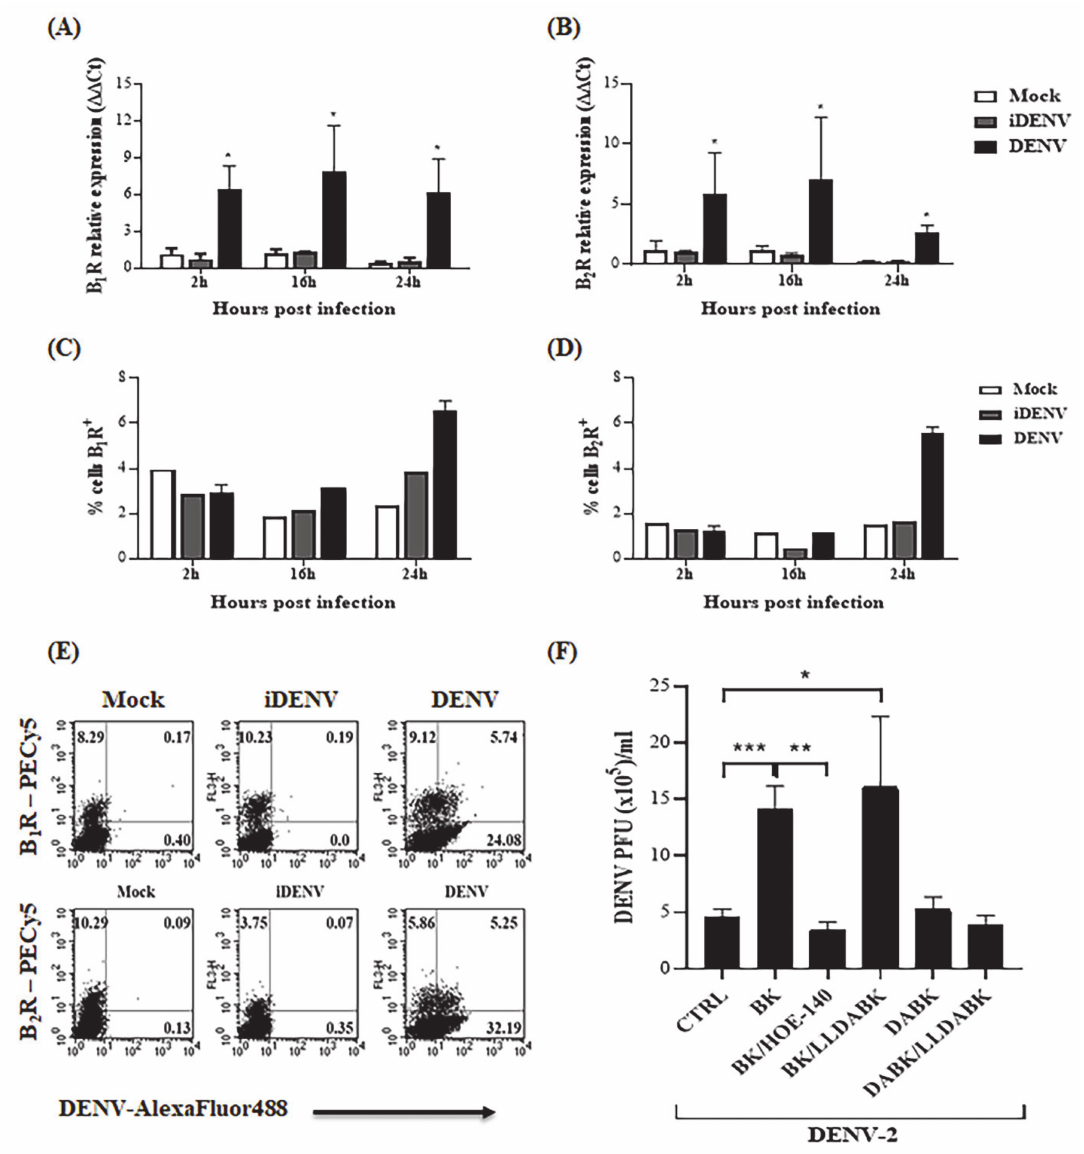
Figure 1. Bradykinin enhances DENV infection in HBMECs in a B2R-dependent way. ( A – D ) HBMECs were mock-treated or cultured with DENV-2 in its native or UV-inactivated forms (iDENV) for the indicated time points. ( A , B ) The expression of B1R and B2R mRNA were evaluated by qRT-PCR. ( C , D ) HBMECs were either incubated with goat anti-B1R antibodies or rabbit anti-B2R (Invitrogen), fixed and stained with secondary anti-goat or anti-rabbit antibodies, respectively. Surface expression of B2R and B1R in HBMECs was measured by flow cytometry; the results are exhibited as the percentage of cells expressing the receptors (% cells), considering staining values obtained in absence of primary antibodies as controls. ( E ) HBMECs cultivated for 24 h in the presence or absence of infectious or inactivated virus as described above were harvested and incubated with rabbit anti-B2R or anti-B1R (Santa Cruz). The cells were then permeabilized and incubated with anti-DENV antibody, followed by incubation with anti-mouse IgG antibody conjugated to AlexaFluor 488. The cells were analyzed by flow cytometry and the figure is a representative quadrant plot of DENV vs. B2R or B1R staining. Insert numbers express the percentage of cells in each quadrant. ( F ) HBMECs were infected with DENV-2 and 24h later, the cells were treated with B2R or B1R agonists-BK or DABK, in the presence or absence of the respective antagonists (HOE-140 and LLDABK). Viral replication was evaluated at 48 h.p.i. by plaque assay. The data are representative of four independent experiments and error bars indicates SD values between replicates in all experiments. * indicates p ≤ 0.05; ** p ≤ 0.01; *** p ≤